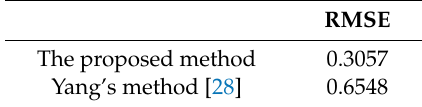
Table 1. The root mean square error (RMSE)